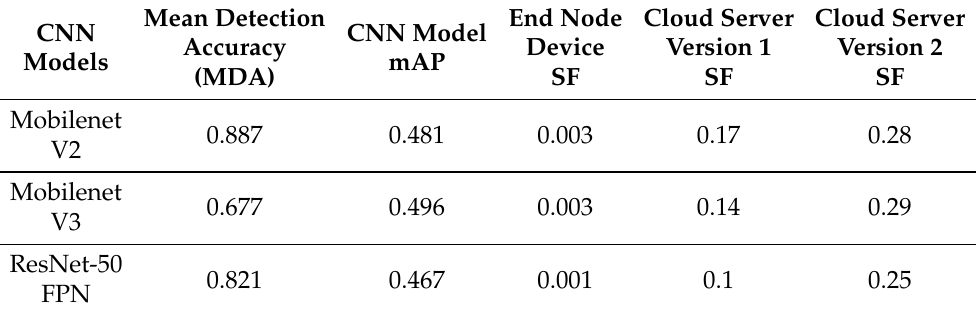
Table 5. Mean Detection Accuracy (human bee counting verification) over models’